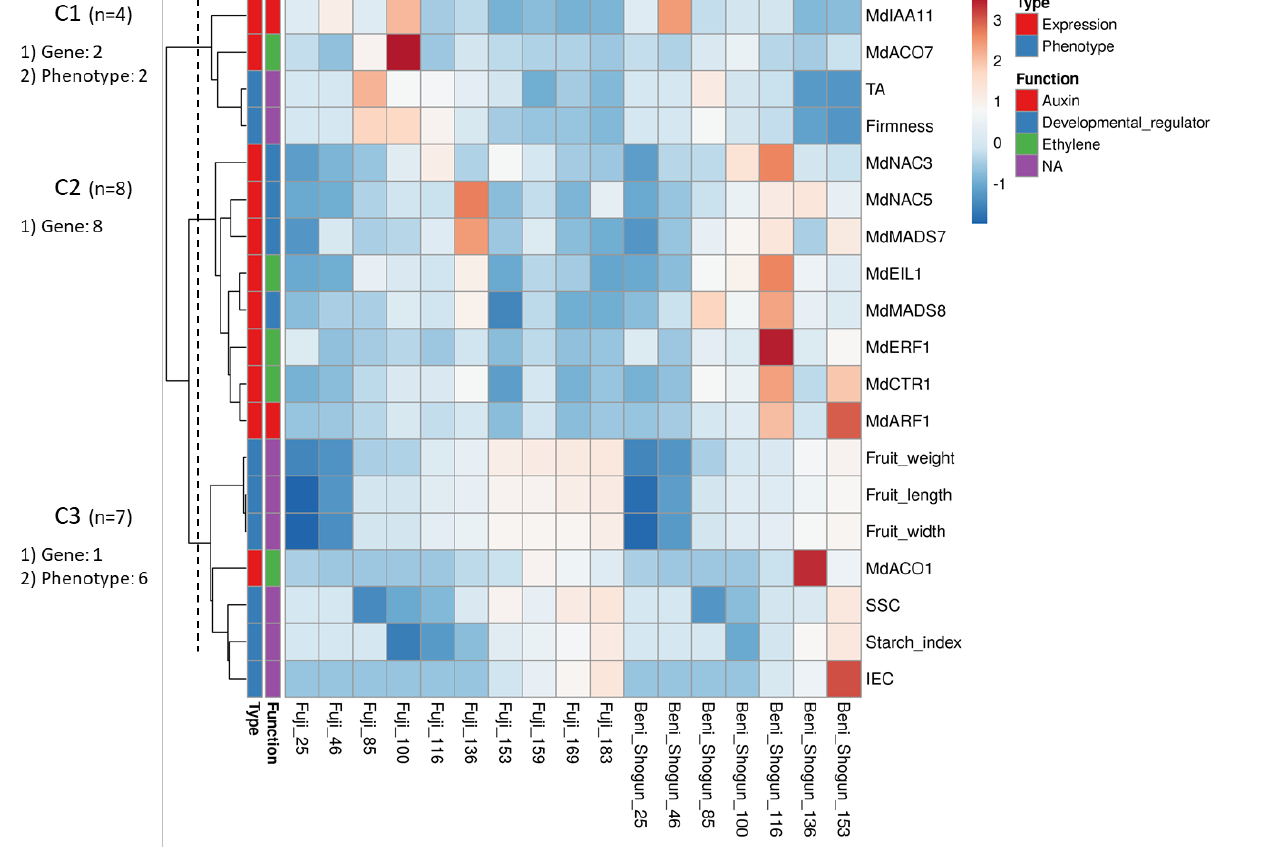
Figure 5. Hierarchical clustering heatmap analysis of 8 phenotypes and 11 genes related to fruit development, maturation, and ripening between ‘Beni Shogun’ and ‘Fuji’. They are divided into 3 clusters (C1 to C3). Unit variance scaling is applied to rows.